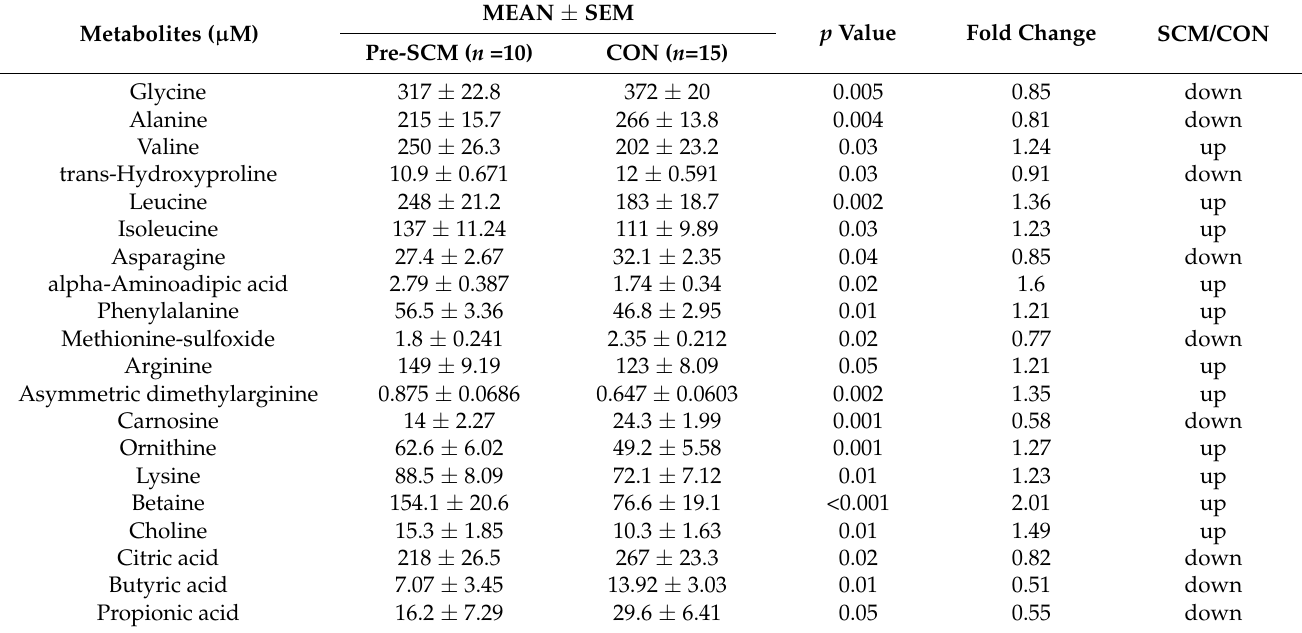
Table 4. Concentration of serum metabolites (MEAN ± SEM, ( p ≤ 0.05)) in pre-subclinical mastitis cows only (pre-SCM, n = 10) and healthy controls (CON, n = 15) cows at − 8 weeks before parturition, as identified by